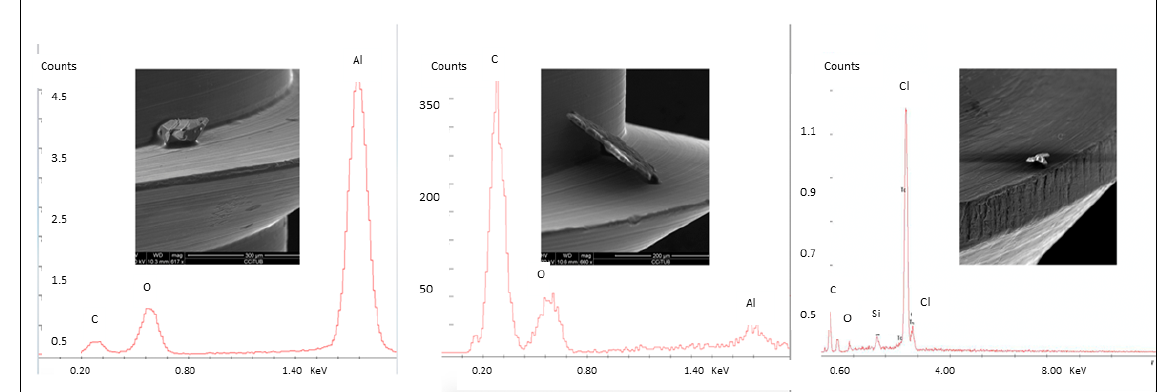
Figure 1. ( a–d ) : Surface irregularities and metal spikes as viewed by the Scanning Electron Microscope (SEM). From left to right: ( a ) Dual Top, ( b ) Spider®, ( c ) Microdent, ( d ) Absoanchor®. ( e ) : Count of contaminating particles (white dots) on the body of the visi- ble side of an orthodontic mini-implant (OMI).